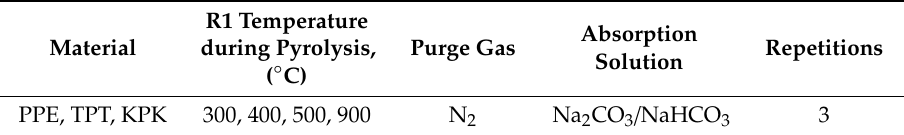
Table 3. Experimental conditions—pyrolysis experiments.